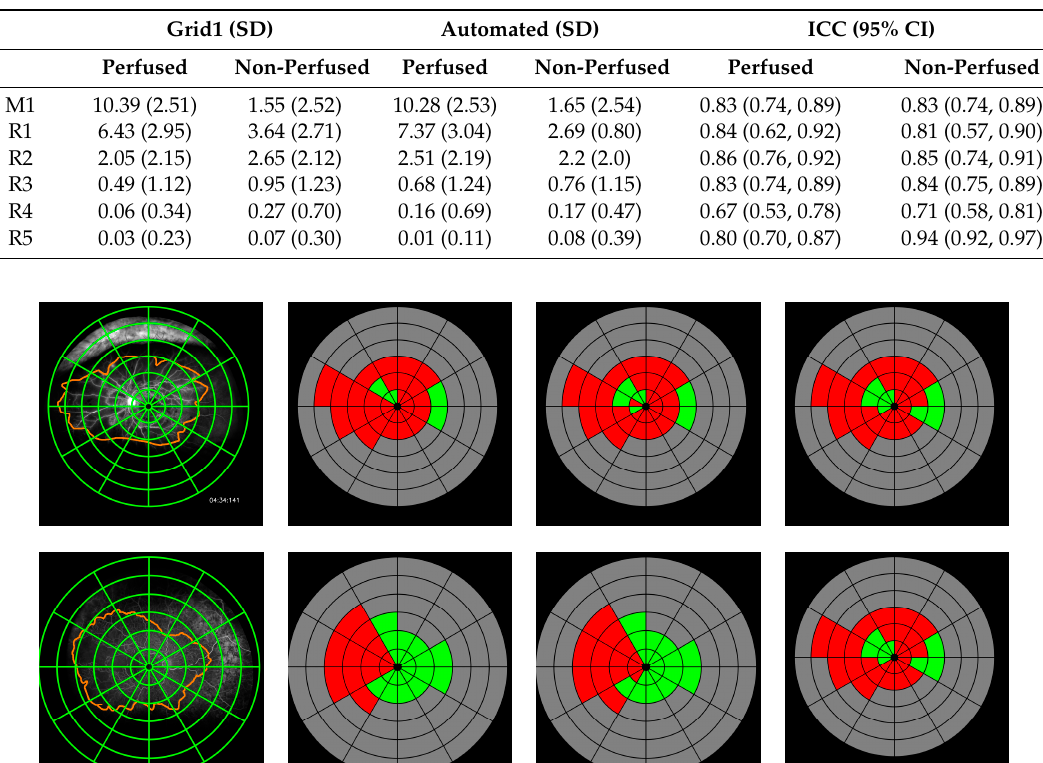
Figure 5. Grid assessment examples. Left to right: FA image, grid annotation from grader 1, automated assessment, grid annotation from grader 2 (Kappa values. Ex. 1: Auto 0.80, Grid2 0.65; Ex. 2: Auto 0.93 Grid2 0.74; Ex.3: Auto 0, Grid2 0.08). 4. Discussion In our study, we explored the viability of deep learning-based quantification of CNP, and propose an implementation that demonstrates this technology can be used to diagnose and monitor CNP progression. Our implementation uses a fully convolutional deep learning method to extract a CNP dense segmentation. Subsequently, an automatic grid assessment is performed, to provide a repeatable description of the topographical distribution of the CNP regions. Developing and validating deep learning algorithms is a rapidly advancing field in medicine, with a desire to rapidly translate to practice, to ease the pressures of the exponential increase in clinic appointments in all health sectors. Whilst most of these algorithms are developed to diagnose conditions that can be already well-ascertained by clinicians, they also have a role in situations where clinicians face challenges in accurately measuring pathological findings, even if time factor is not an issue. Here, we report a cautious approach of development and validation of a supervised deep learning algorithm in such a scenario, and enumerate the challenges faced and the proposed solutions. The study is performed on a newly created dataset limited to 75 UWF-FA images, manually segmented and graded by experts. Please note that the dataset’s size compares favorably with complementary datasets (DRIVE, STARE) used for assessing retinal vessel segmentation algorithms [25,26]. We have shown that dense segmentation of CNP regions is a challenging task for both human graders and deep learning-based models. The performance reached by the fully convolutional network was similar to that obtained by human grader agreement. That behaviour has been confirmed when investigating the distribution of CNP in the concentric rings. Intergrader agreement has shown second grader had identified more regions as non-perfused, annotating 36.33% (12.93) of the gradable retina, compared to grader 1 annotation of 25.63% (12.81). Nonetheless, as reflected by